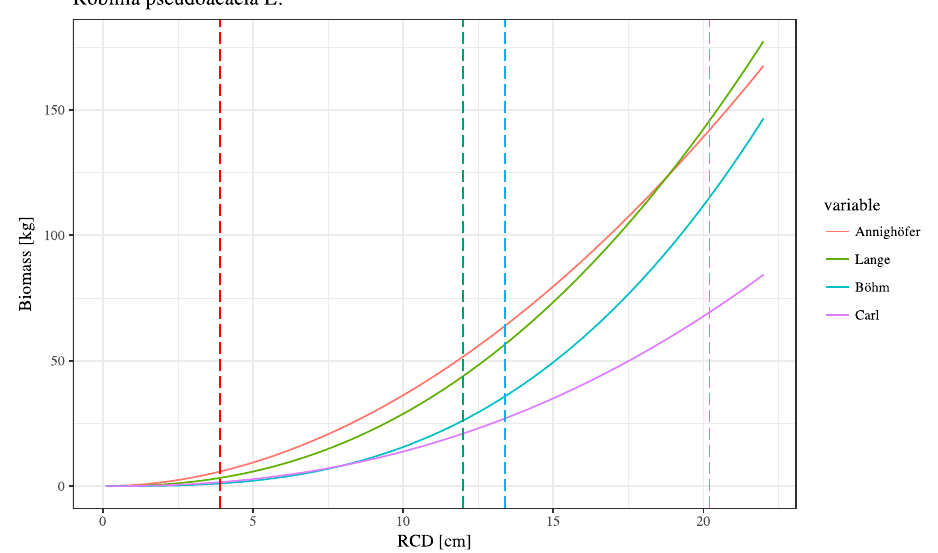
Figure 3. Biomass equations comparing Robinia pseudoacacia L. biomass to RCD of different investigations, including the current study M 01 , Lange et al. [41], Annighöfer et al. [42], and Böhm et al. [20]. The dashed line illustrates the maximum RCD, which was incorporated into the biomass